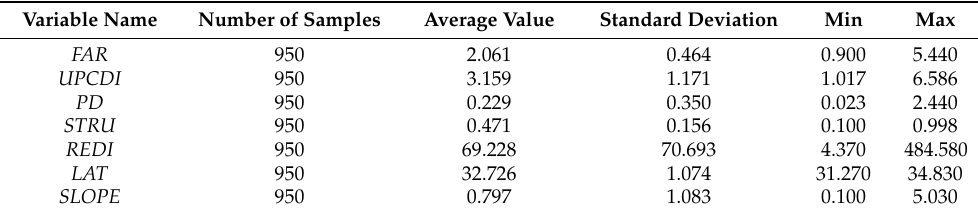
Table 1. Descriptive statistics of